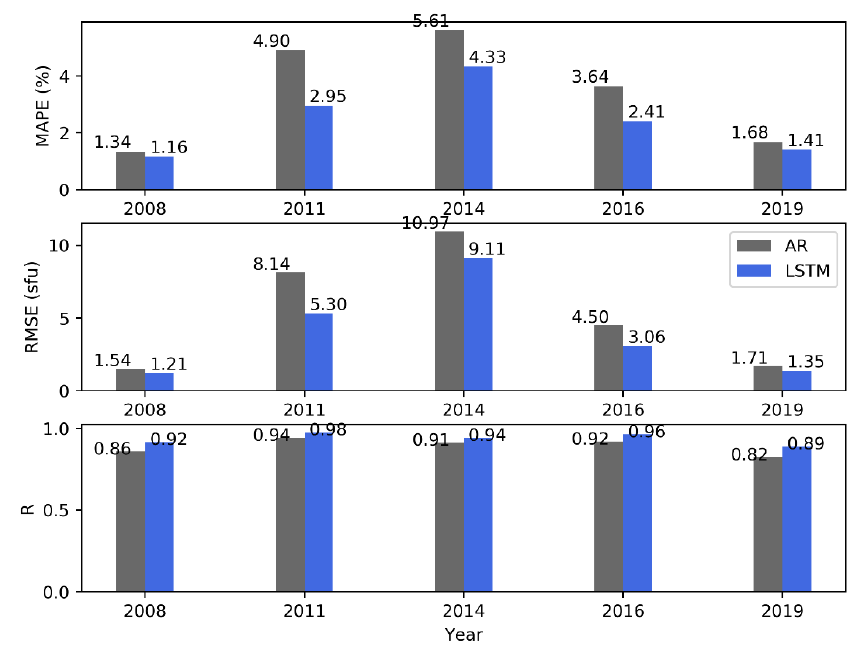
Figure 10. The same as Figure 9 but for 2-day prediction of models.